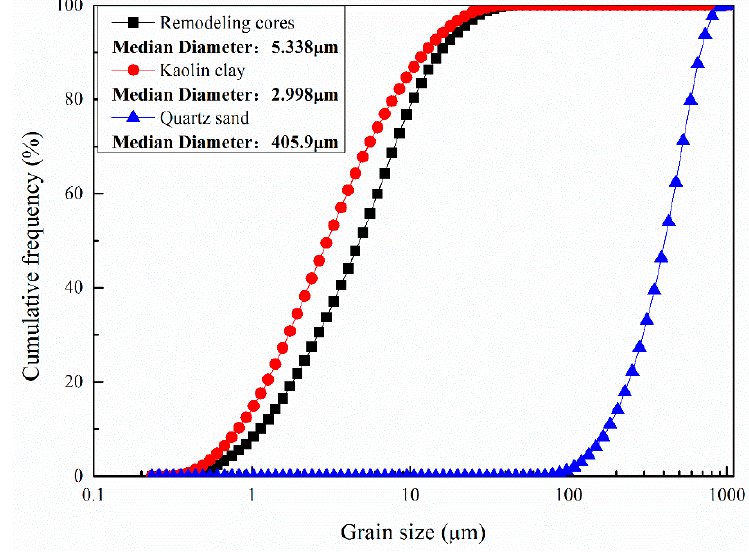
Figure 5. Particle size distributions of sediment matrices.